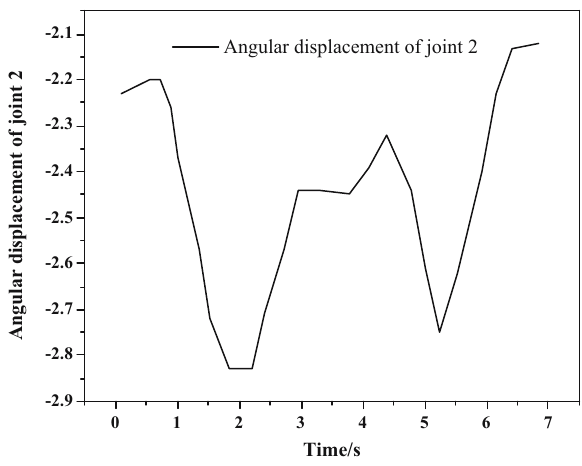
Figure 5: Angular displacement curve of optimized cubic B - spline programming joint 2.